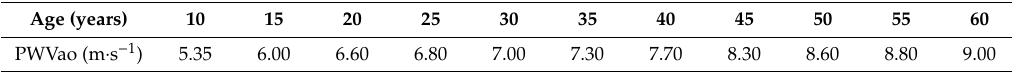
Table 3. Median PWVao values and age of the Central European population according to Reference